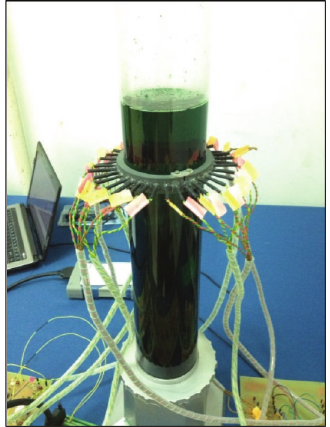
Figure 9: The condition of 25% of air